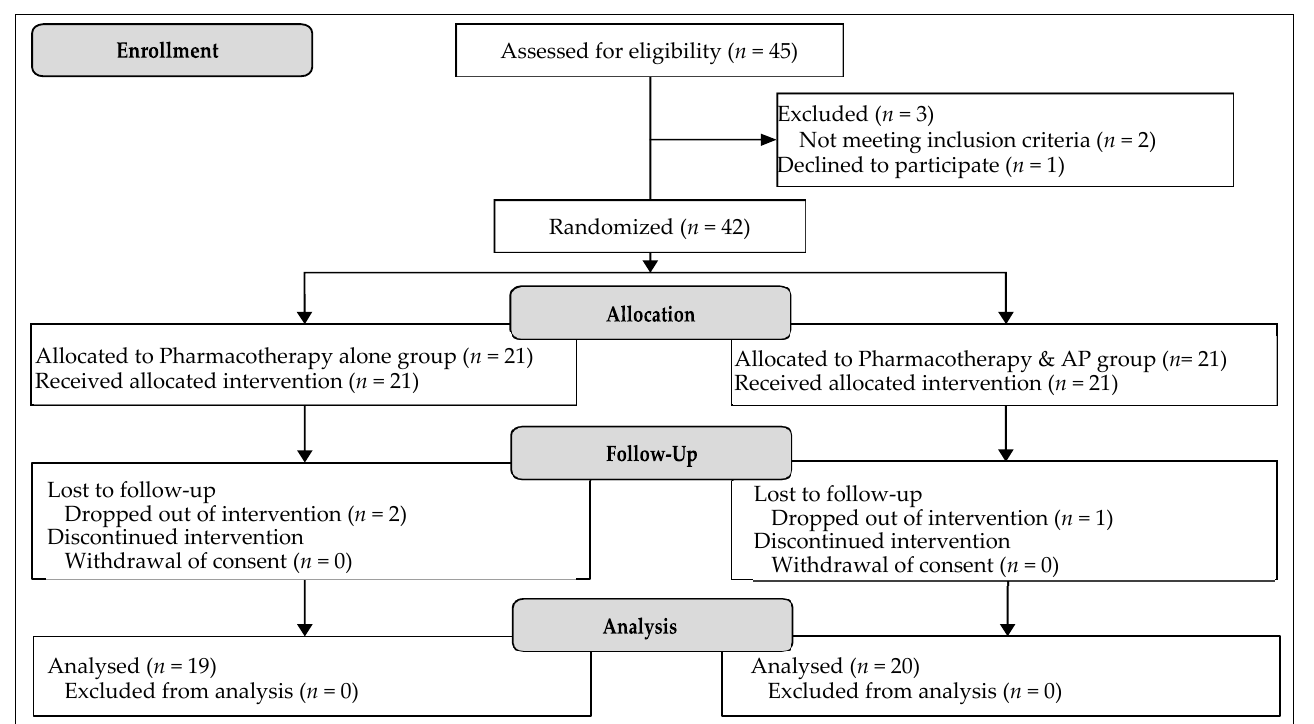
Figure 1. CONSORT flow diagram.